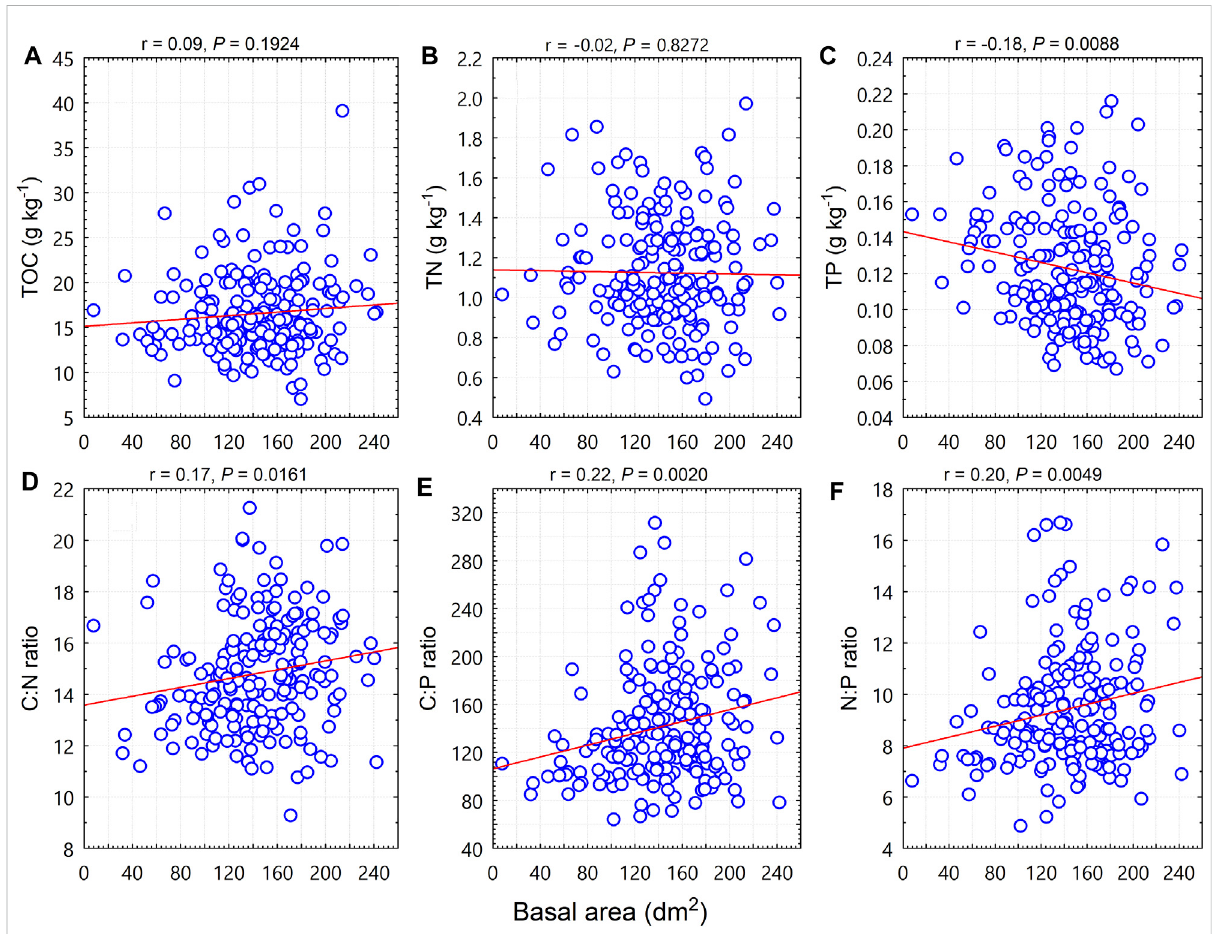
FIGURE 2 Relationshipsbetweenwoodyplantbasalarea(BA,dm 2 )andsoiltotalorganiccarbon(TOC),totalnitrogen(TN),totalphosphorus(TP)contents, and C:N:P stoichiometric ratios at the quadrat